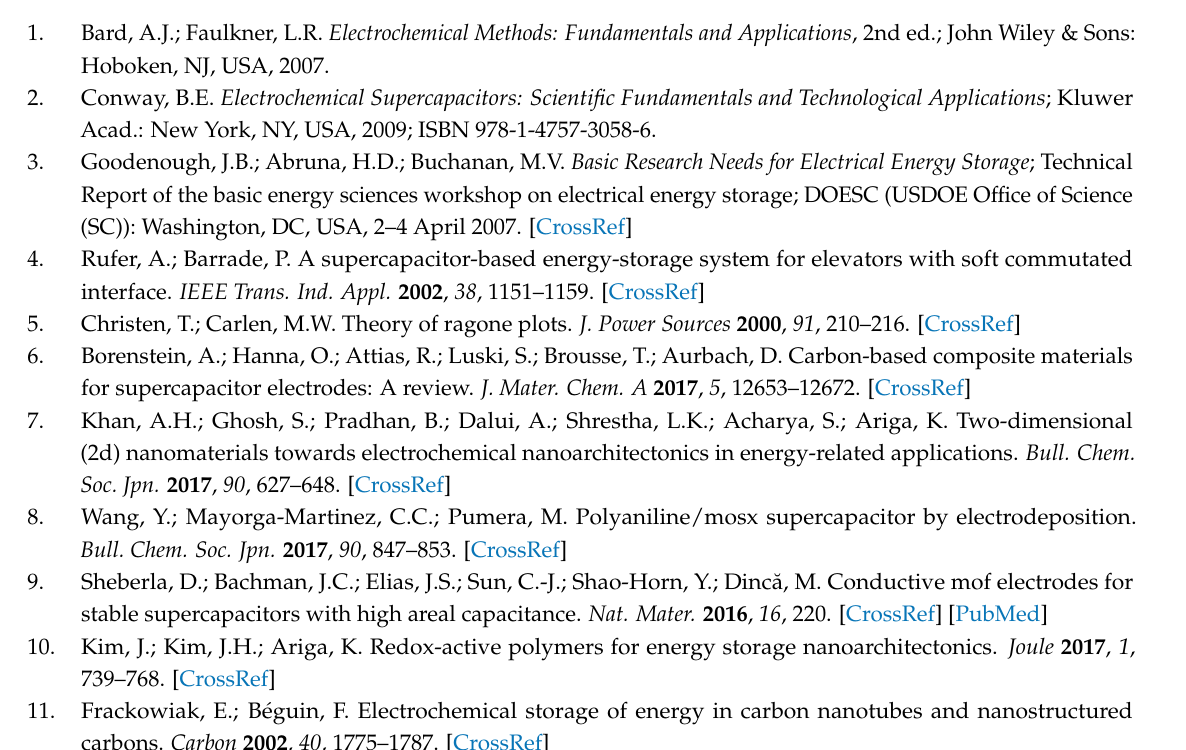
Figure S1: (a) UV-VIS absorbance spectroscopy of LPEG, (b) XPS analysis survey scan, (c) O 1s scan, and (d) C 1s scan. Figure S2: (a) Cyclic voltammetric plot for bulk graphite powder in BMP-FAP, and (b) the resulting specific capacitance vs scan rate used. Figure S3: (a) Cyclic voltammetric plot of LPEG in 6M KOH aqueous electrolyte, and (b) the resulting specific capacitance vs scan rate used. (c) Cyclic voltammetric plot of LPEG in BMIM-PF6 ionic liquid electrolyte and (d) the resulting specific capacitance vs. scan rate used. Table S1: Specific capacitance (Csp) (in F/g) for all scan rates and voltage windows that were taken for